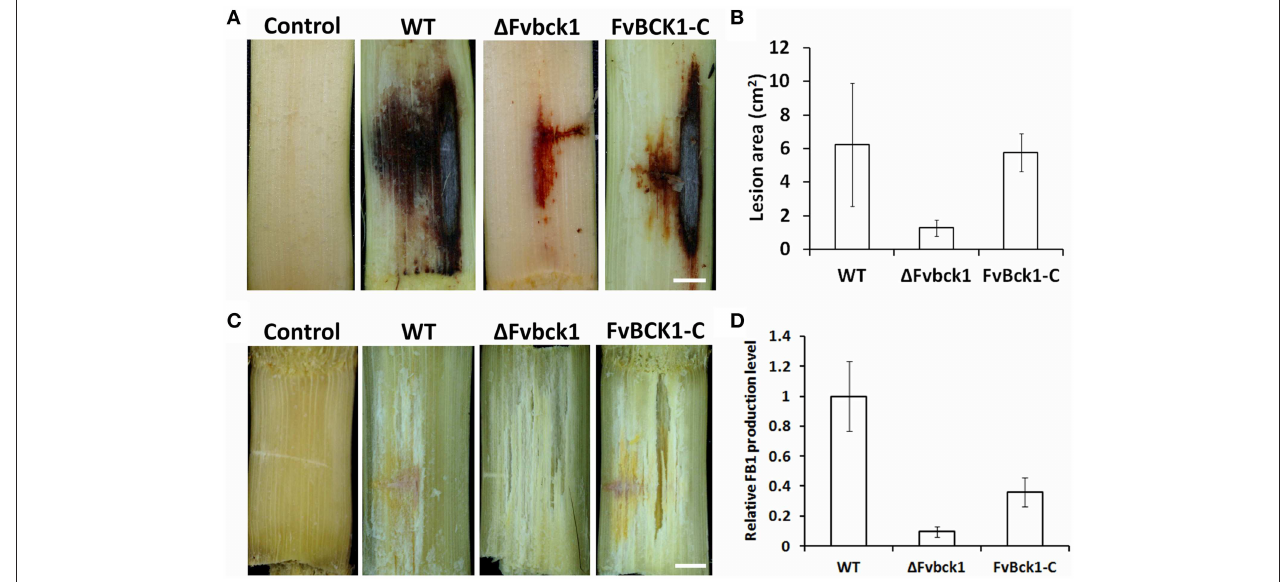
FIGURE 3 | Infection assays and FB1 production of WT, 1 Fvbck1, and FvBck1-C strains. (A) Disease symptom of sugarcane stems infected with 10 6 conidia of each strain for 7 days. Bar = 1cm. (B) Lesion area of longitudinally dissected sugarcane stalk infected with each strain for 7 days. (C) Hyphal growth observed in the autoclaved sugarcane stems inoculated with 10 6 conidia of each strain for 7 days. Bar = 1cm. (D) Relative FB1 production of each strain grown in autoclaved corn kernels for 7 days. FB1 levels were analyzed after normalization, and the average production level of WT strain was set to